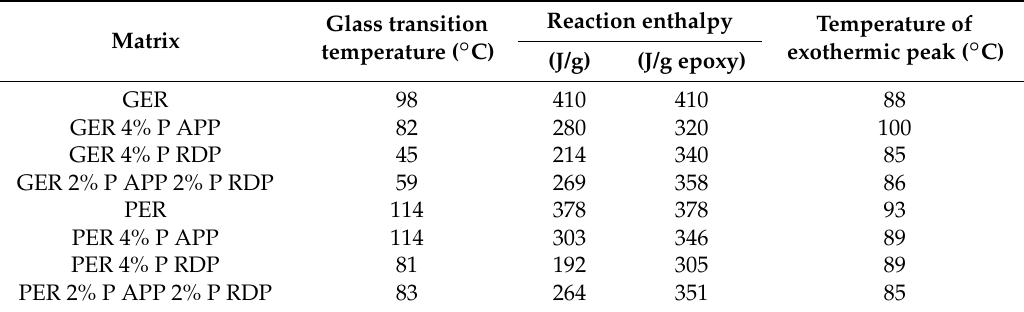
Table 3. Effect of the additive flame retardants on the glass transition temperature, reaction enthalpy and temperature of the exothermic peak in GER and PER matrix